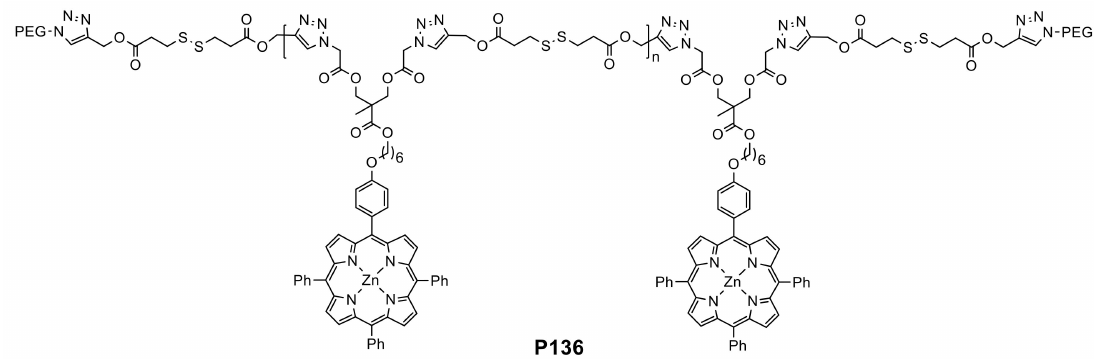
Figure 11. Structure of the PEG-terminated ZnTPPC 6 -based